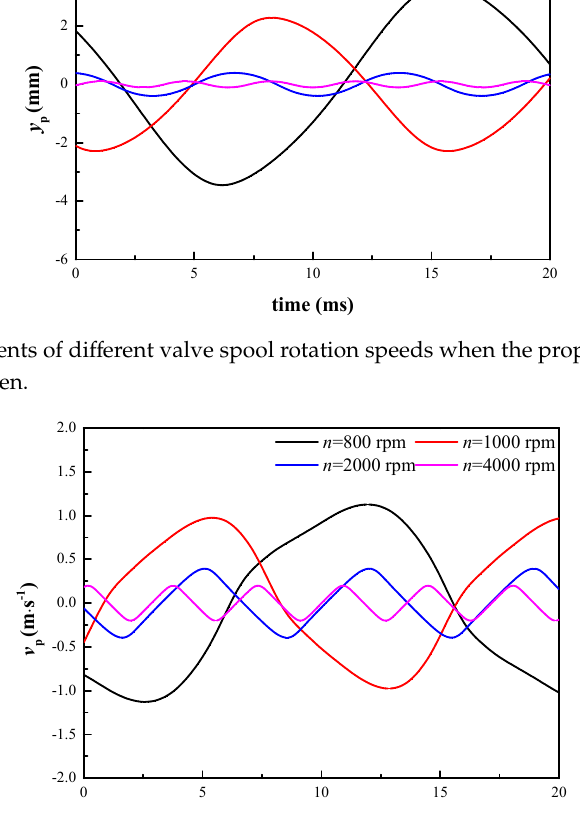
Figure 8. Velocities of different valve spool rotation speeds when the proportional flow control valve port is fully open.